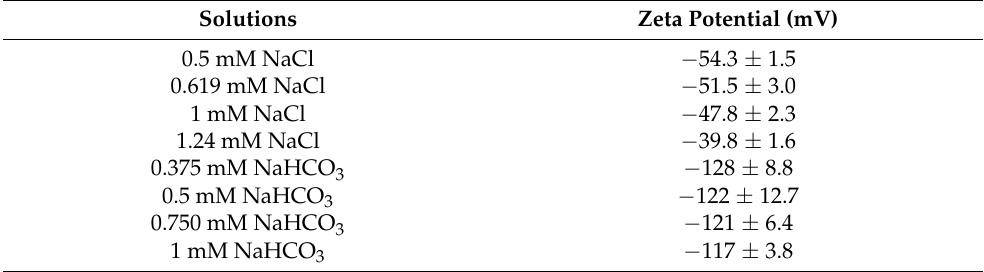
Table 3. Measured zeta potential values of solutions for numerical simulations.